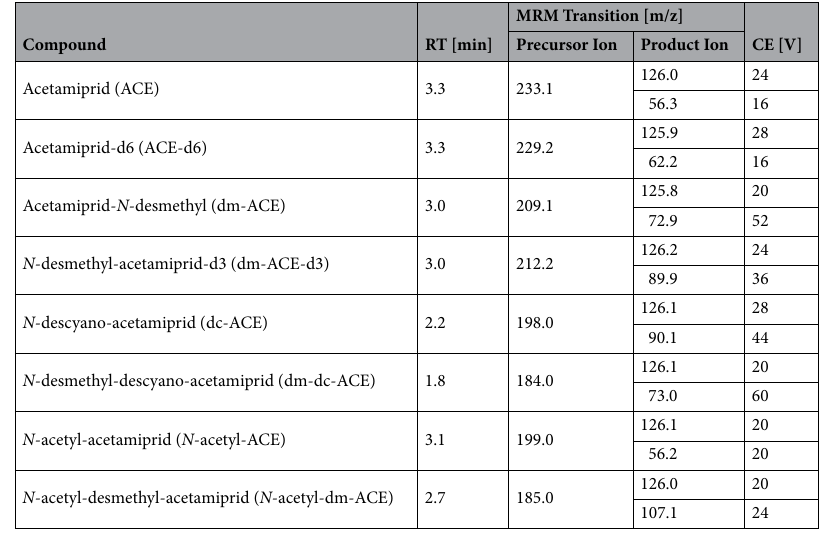
Table 1. LC/MS parameters for ACE and its metabolites. Target ion is the product ion listed in the top column of each compound. Other product ions are used as qualifier ions. Abbreviations: LC/MS liquid